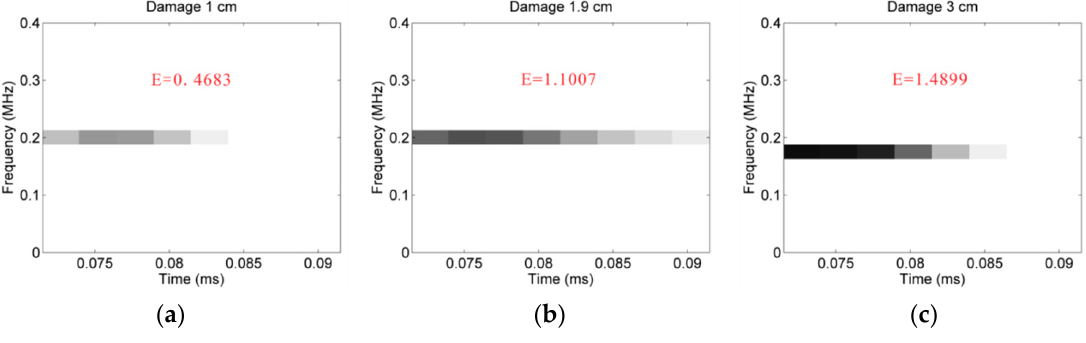
Figure 9. Energy density spectra for the different diameters of delaminations: ( a ) 1.0 cm; ( b ) 1.9 cm; ( c ) 3.0 cm.